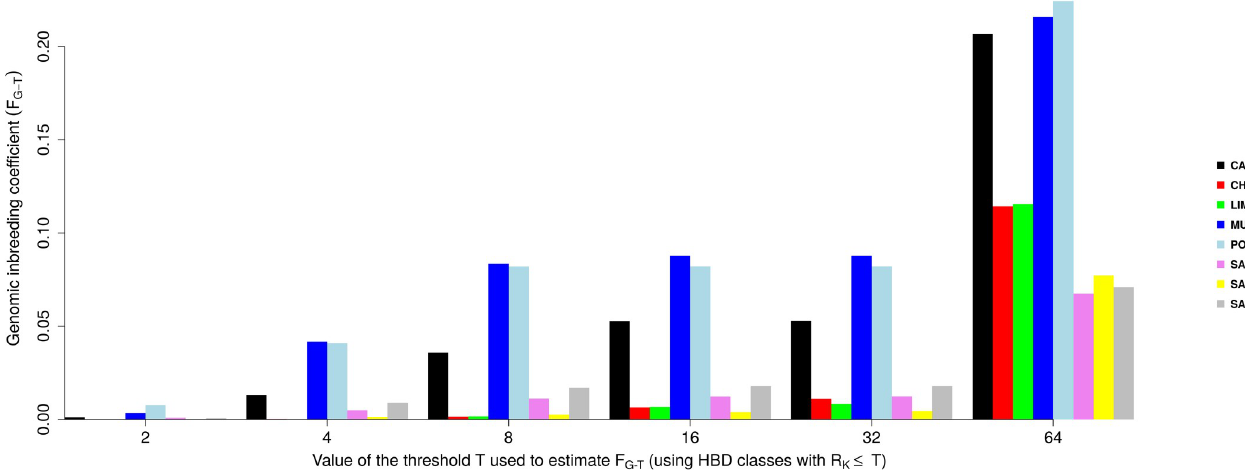
Fig 8. Proportion of the genome consisted of HBD classes in different RK. CAL = Calvana; CHA = Charolais; LIM = Limousine; MUP = Mucca Pisana; PON = Pontremolese; SAB = Sardo Bruna; SAM = Sardo Modicana; SAR =